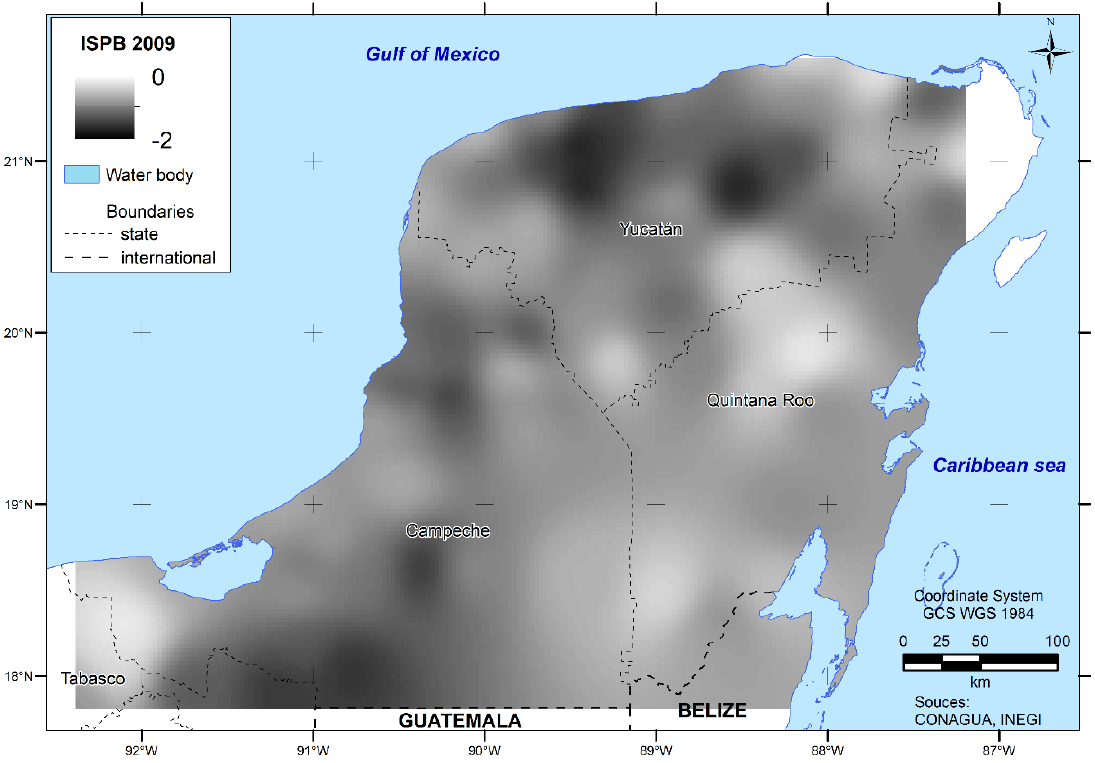
Figure 3. Spatial variation of the 2009 pre-summer drought measured with the ISPB index.